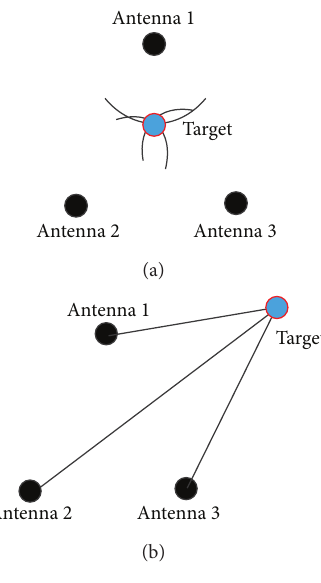
Figure 1: Two types of TOA technique. (a) Object is enclosed within the antennas. (b) Arrangement of three antennas in the short baseline